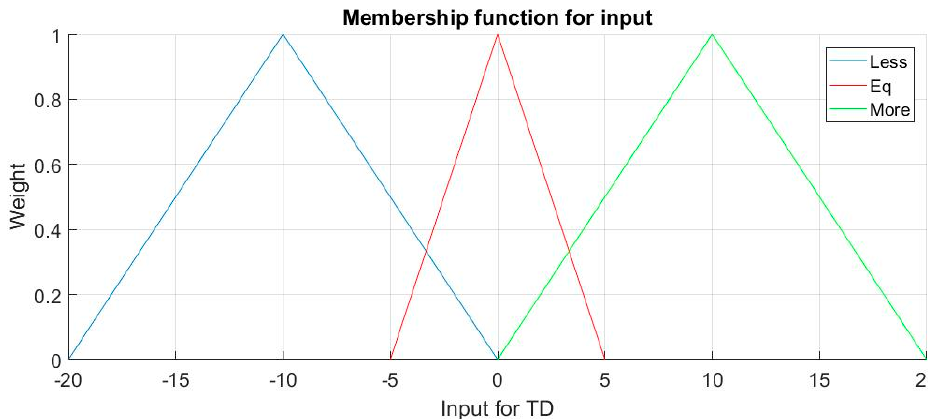
Figure 6. Membership functions µ (x) for input TD 12 and TD 23. TD: temperature difference.